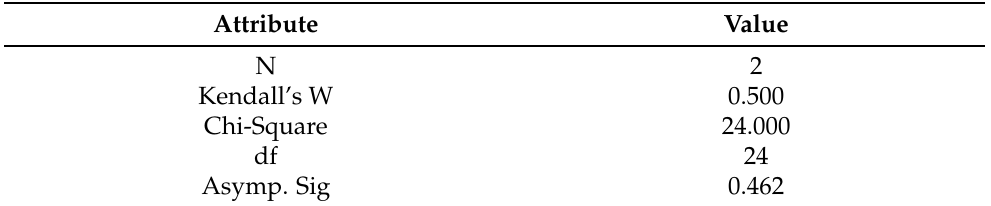
Table 3. Kendall’s W result for lambsquarters classification rate.